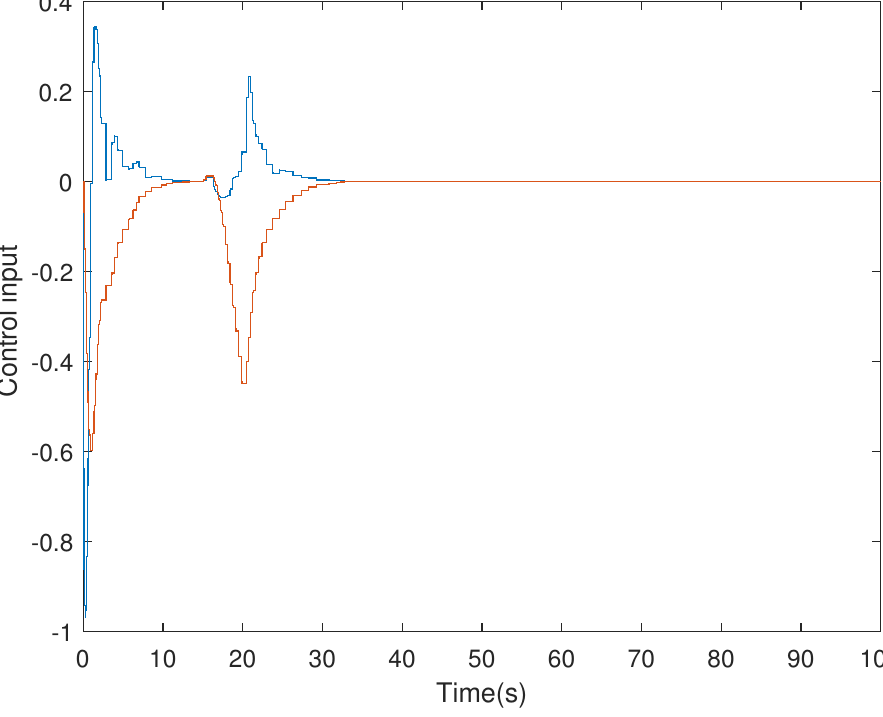
Figure 7. Control input of the LFC system based on the adaptive ETS in Case